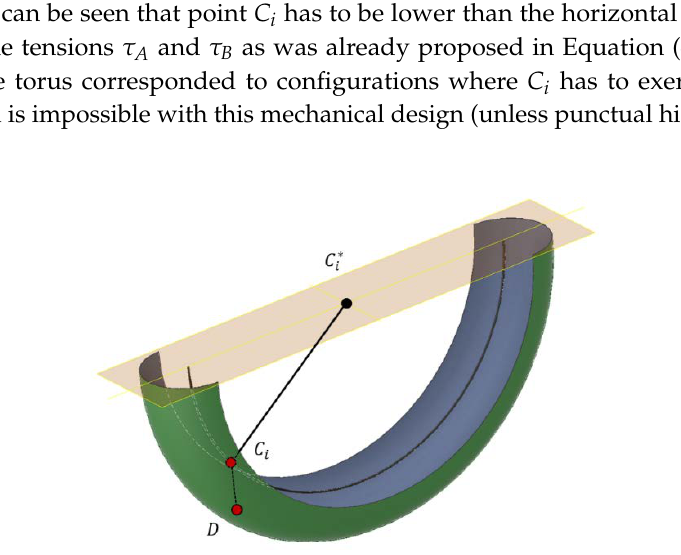
Figure 7. Geometric region of valid existence of point D.